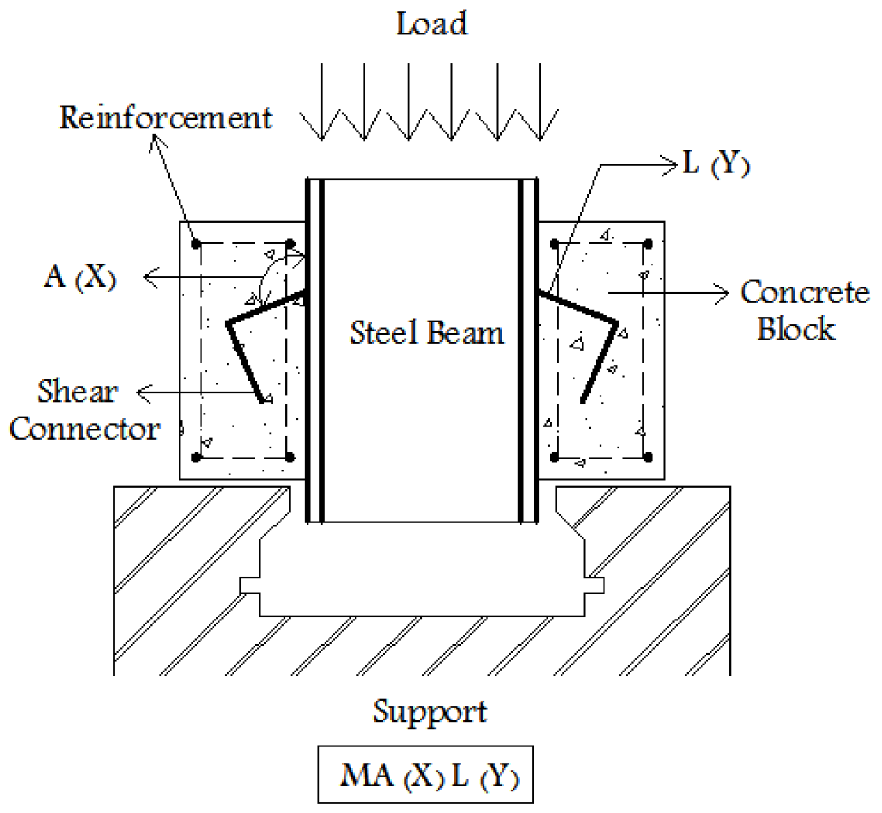
Fig 2. Schematic push-out test setup and symbols for naming.